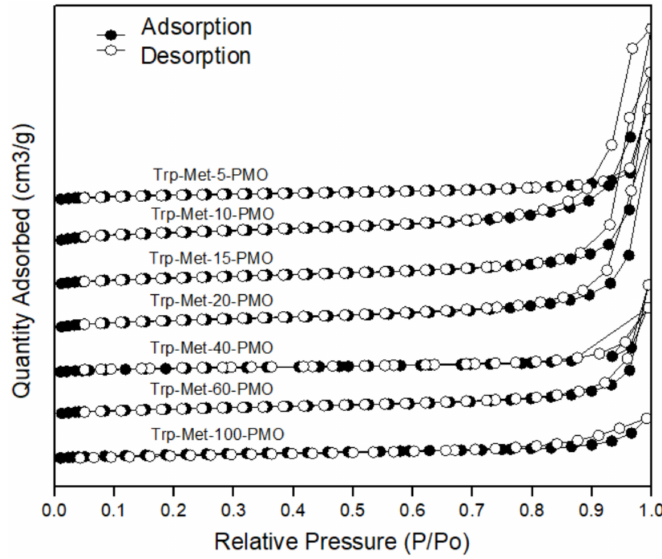
Figure 3. Nitrogen adsorption–desorption isotherms of Trp-Met-x-PMO (x = 5, 10, 15, 20, 40, 60,